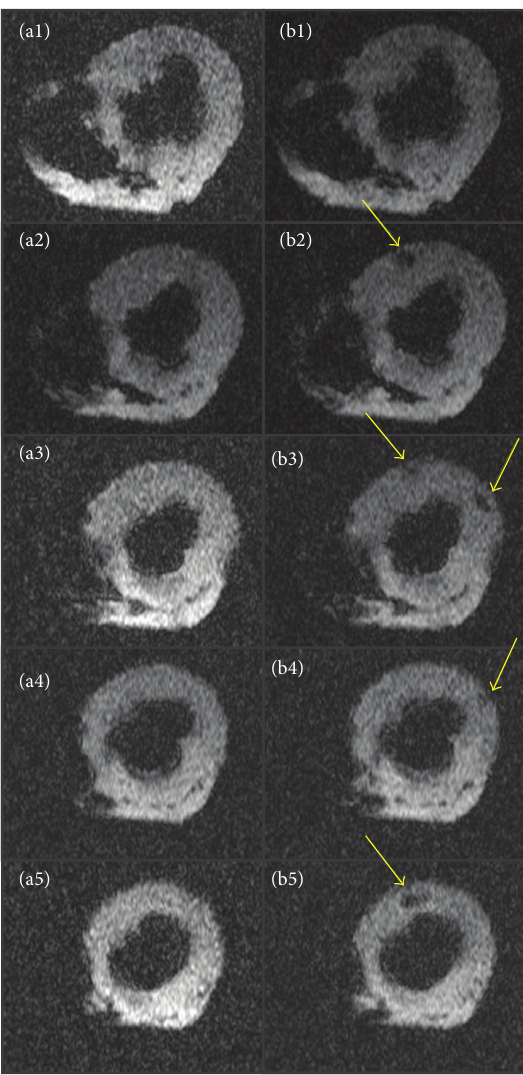
Figure 5: MRI images of porcine myocardium before and after USPIO labeled MSC injection. T2 ∗ -images of porcine myocardium beforeinjection(a1–a5)andafterinjection(b1–b5)ofUSPIO-labeled MSCs. USPIO labeled MSCs are identified as hypointense areas (arrows). MSCs: mesenchymal stromal cells. USPIO: ultrasmall superparamagnetic iron-oxide.